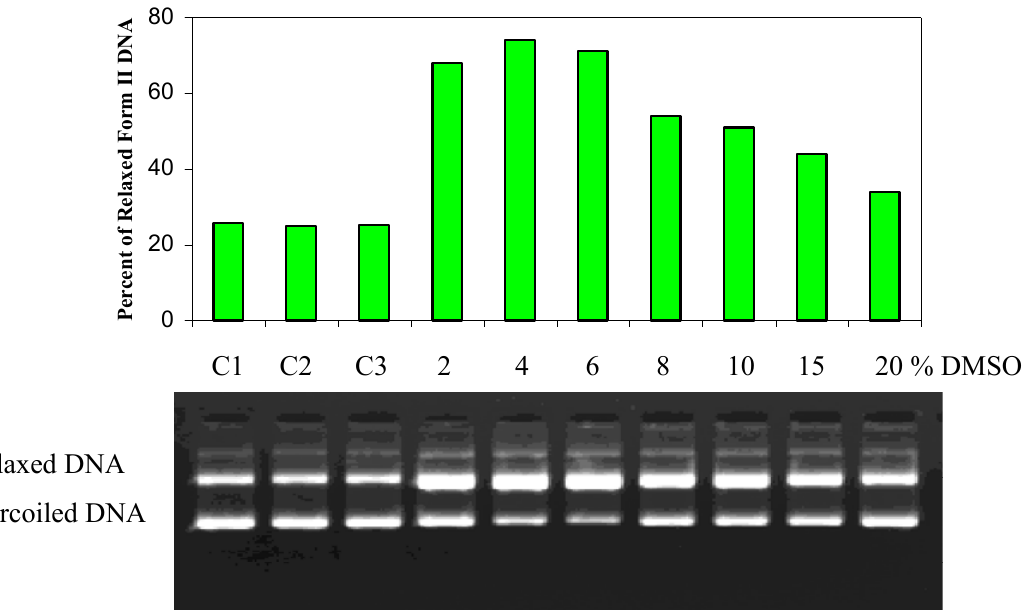
Figure 1. Effect of DMSO on light-induced DNA cleavage by 1-Aminopyrene (1-AP). All lanes con- tain 27 µM supercoiled plasmid Φ X174 DNA and vairious percent of DMSO and irradiated for 1 hr with a UVA lamp (170 J/cm/h). The original plasmid DNA has about 25% relaxed form as shown in the control lanes C1, C2, and C3. C1: 10% DMSO, no irradiation; C2: 10% DMSO + 6 µM 1- AP, no irradiation; C3: 10% DMSO, 1 h